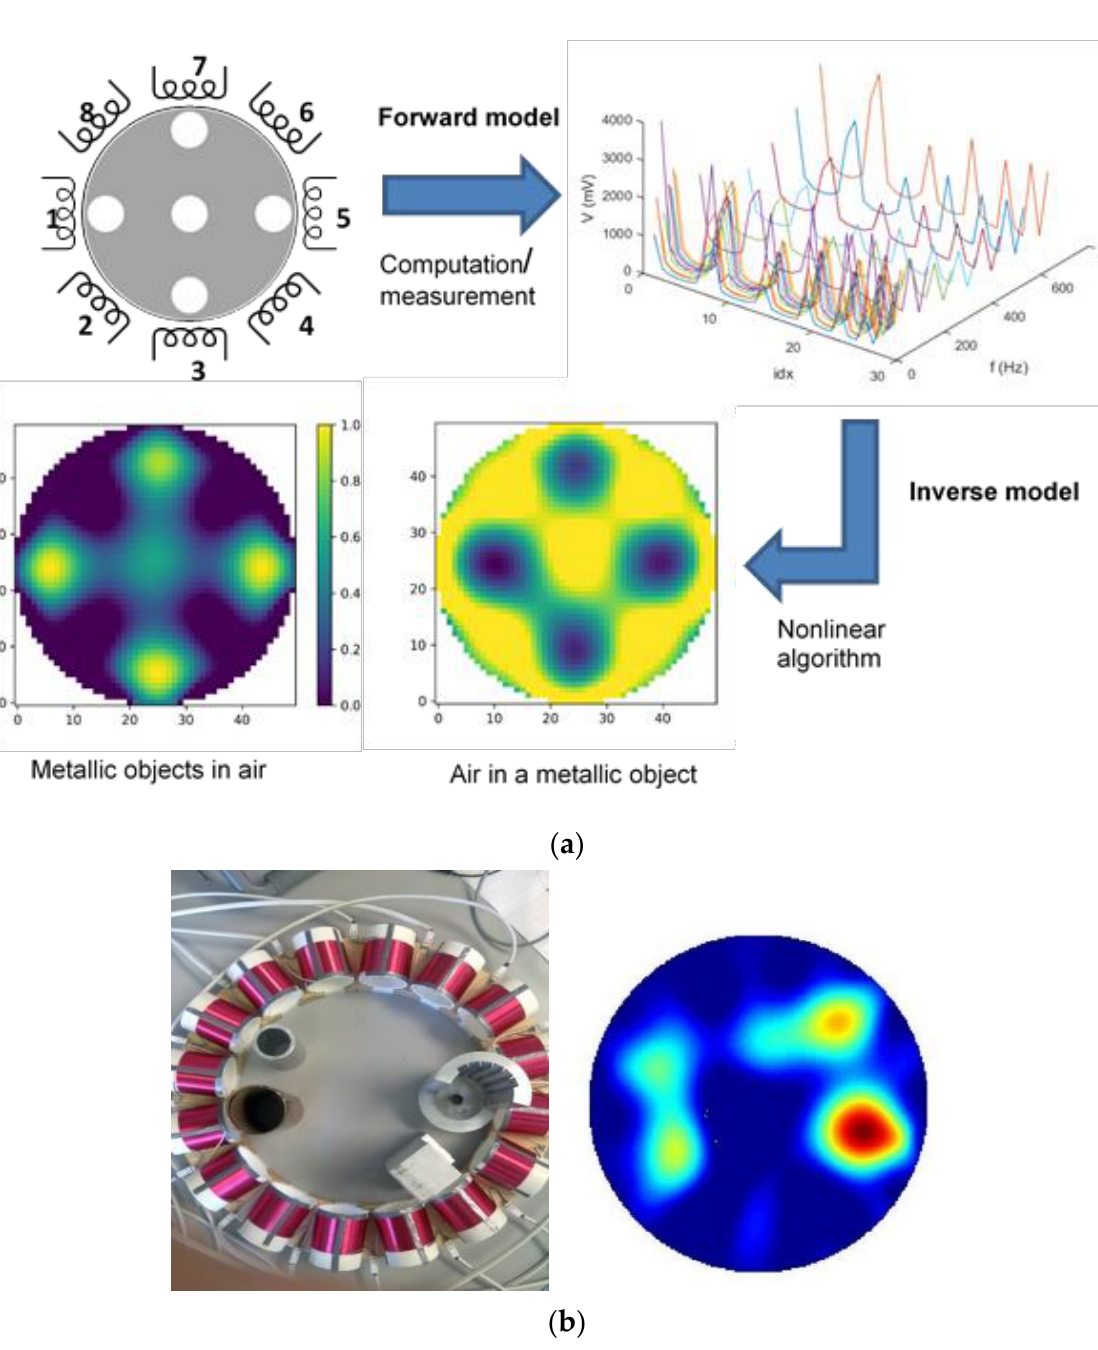
Figure 4. ( a ) MIT imaging process including sensor array (coils 1–8), data collection, and forward modelling, leading to measured induced voltages, 28 measured data (“Idx” denotes the measurement number index), and in various frequencies f, through inverse algorithms, PEP images can be produced. The plot shows the measured MIT data in several frequencies. ( b ) Sensor with multiple inclusions and reconstructed image, the color map represents the electrical conductivity changes.